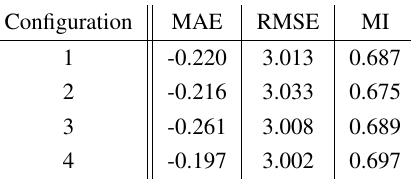
Figure 3. 4D Digital Twins of configurations 1 to 4. The displayed temperatures correspond to 2pm on a typical, i.e. hot and dry summer day in the City of Melville. Table 2. Thermal simulation results for each